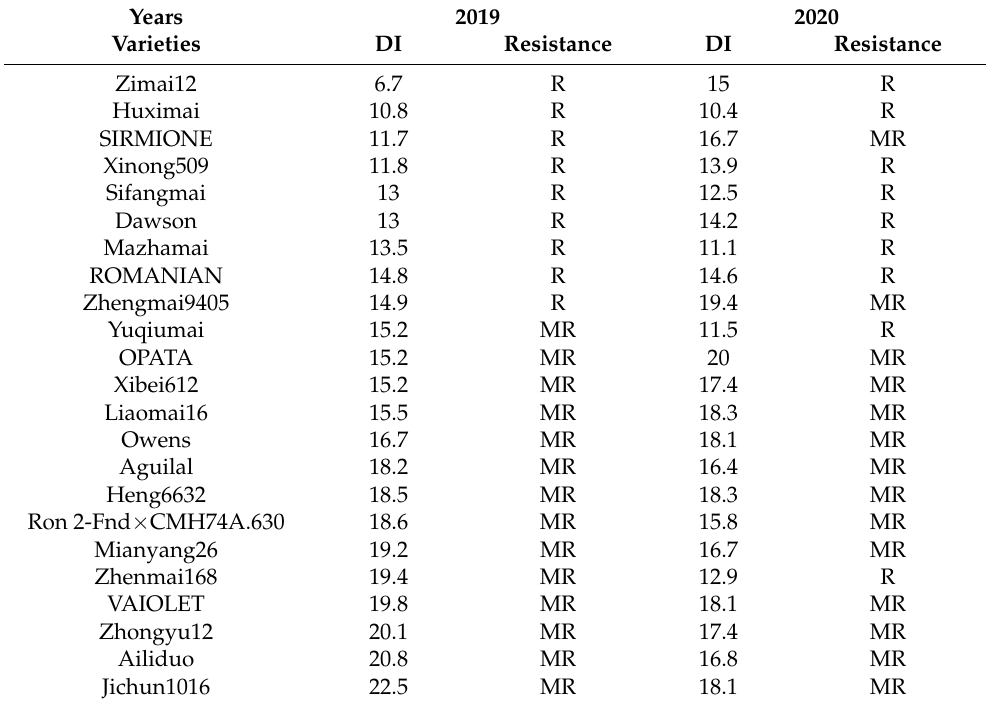
Table 2. Varieties/lines with fine resistance at both